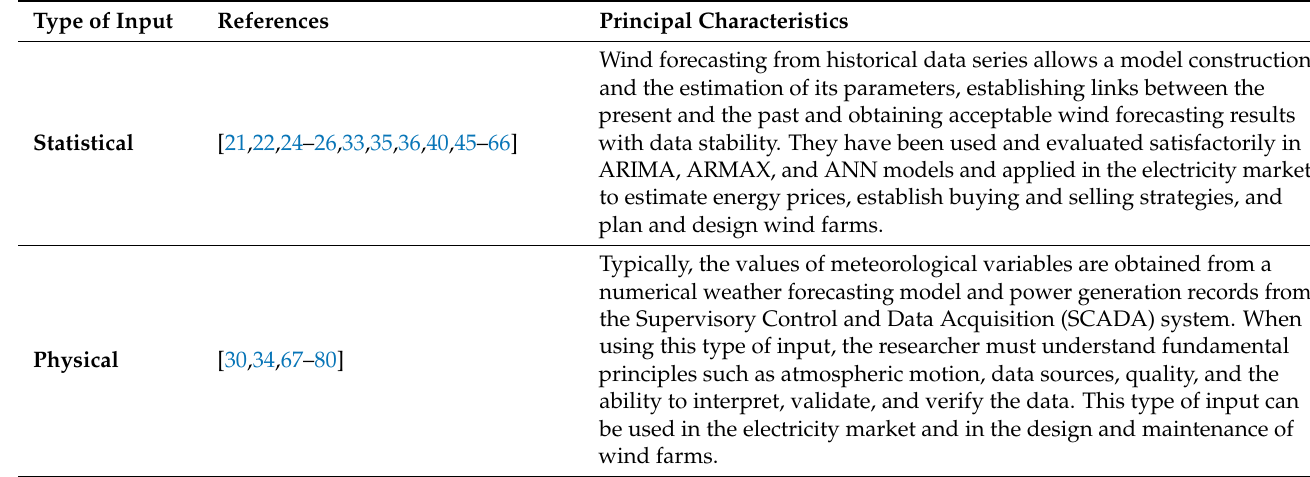
Table 1. Characteristics of type of model